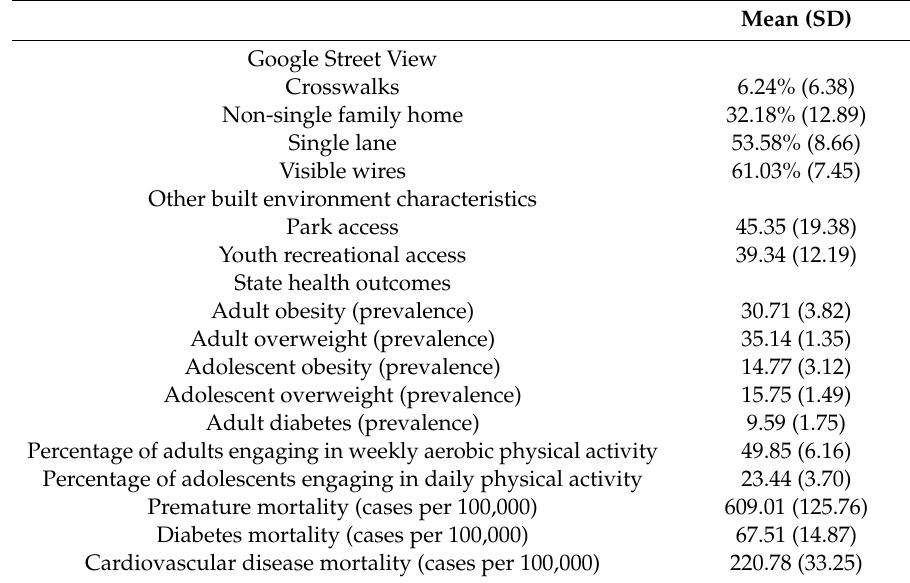
Table 1. Descriptive Statistics, state